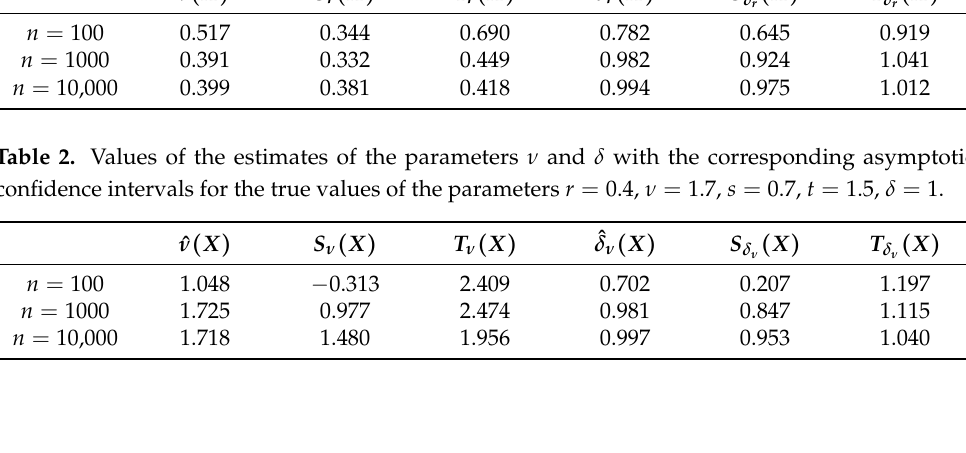
Table 1. Values of the estimates of the parameters r and δ with the corresponding asymptotic confidence intervals for the true values of the parameters r = 0.4, ν = 1.7, s = 0.7, t = 1.5, δ = 1. ˆ r ( X )